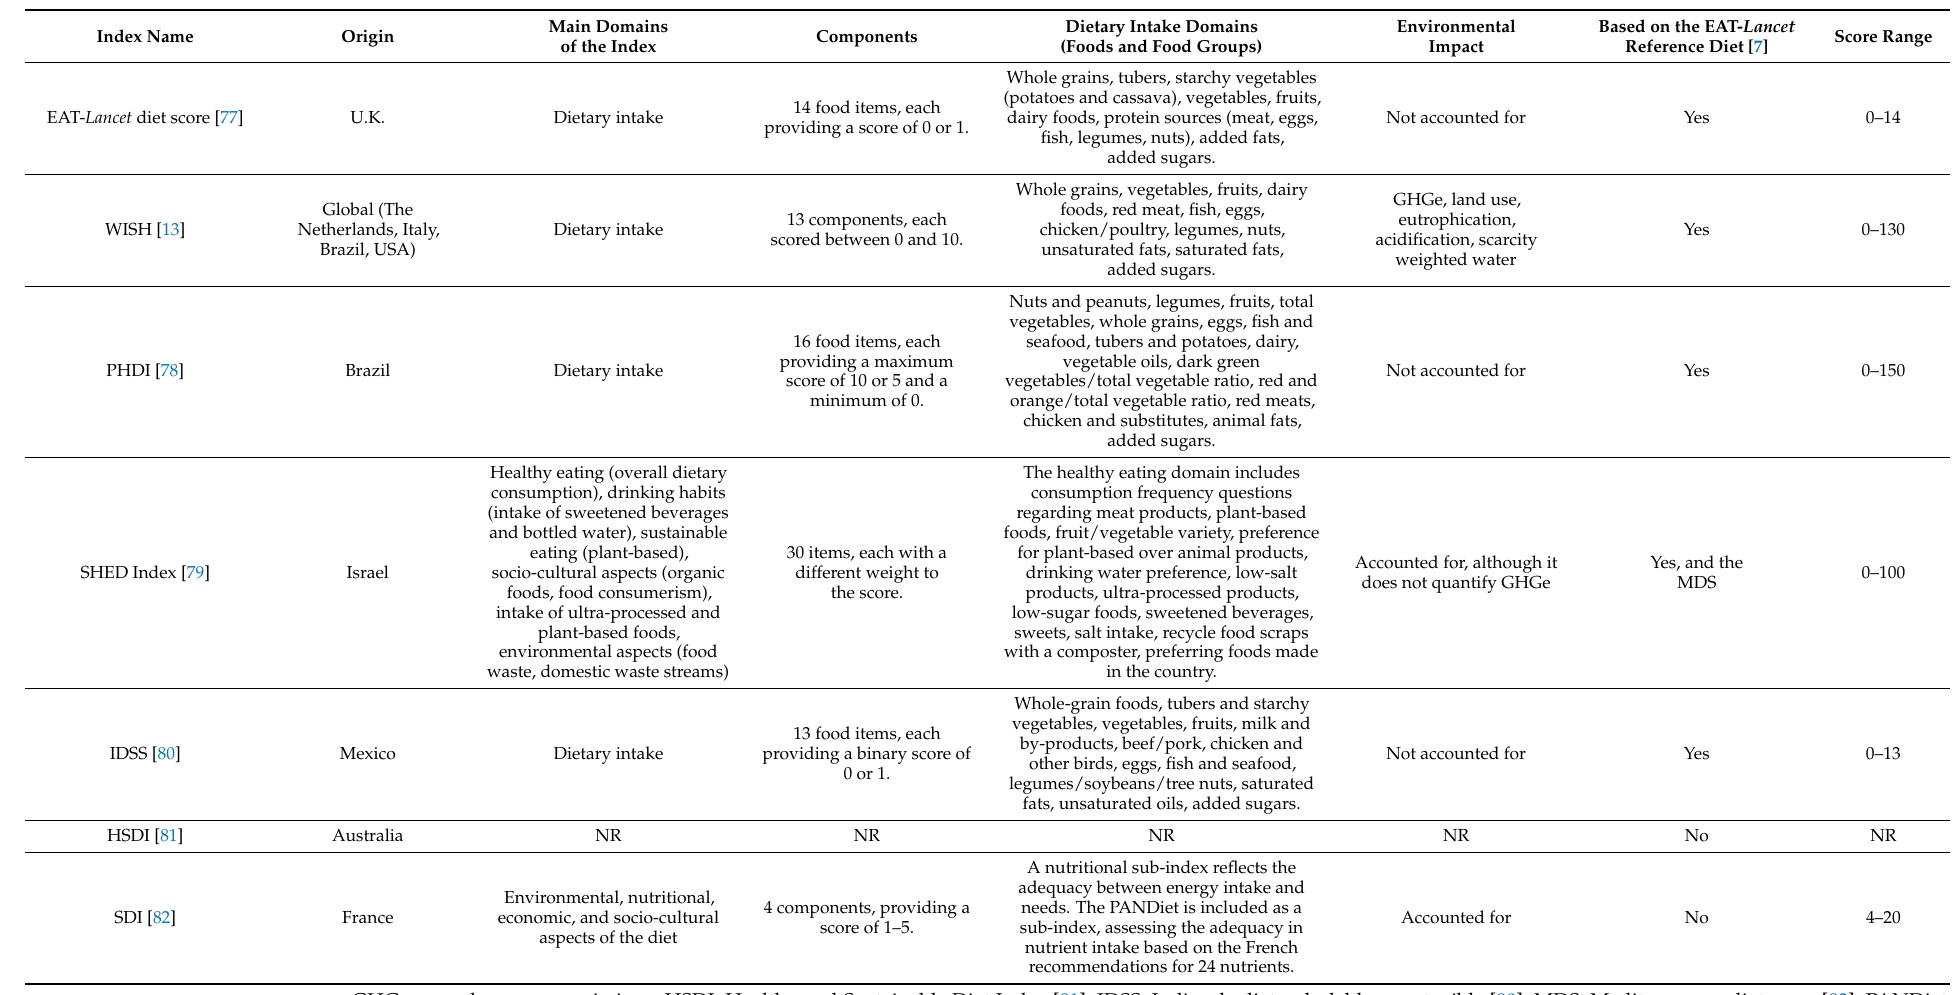
Table 1. Indexes assessing dietary